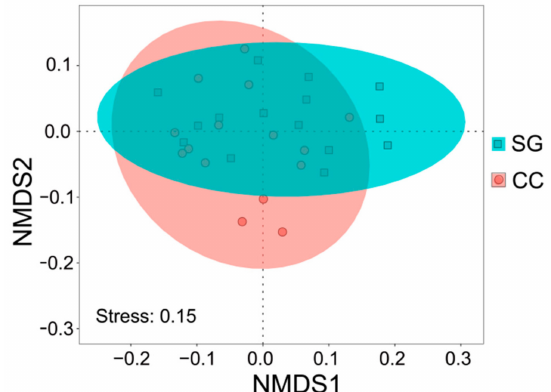
Figure 3. The soil AK content and C / P ratio of small gaps and closed canopy ( n = 15:15). ( a ): AK content of small gaps and closed canopy; ( b ): C / P ratio of small gaps and closed canopy. Paired groups marked by letters a and b or A and B in box plots are significantly di ff erence (based on two-sided independent t -tests, p ≤ 0.05).